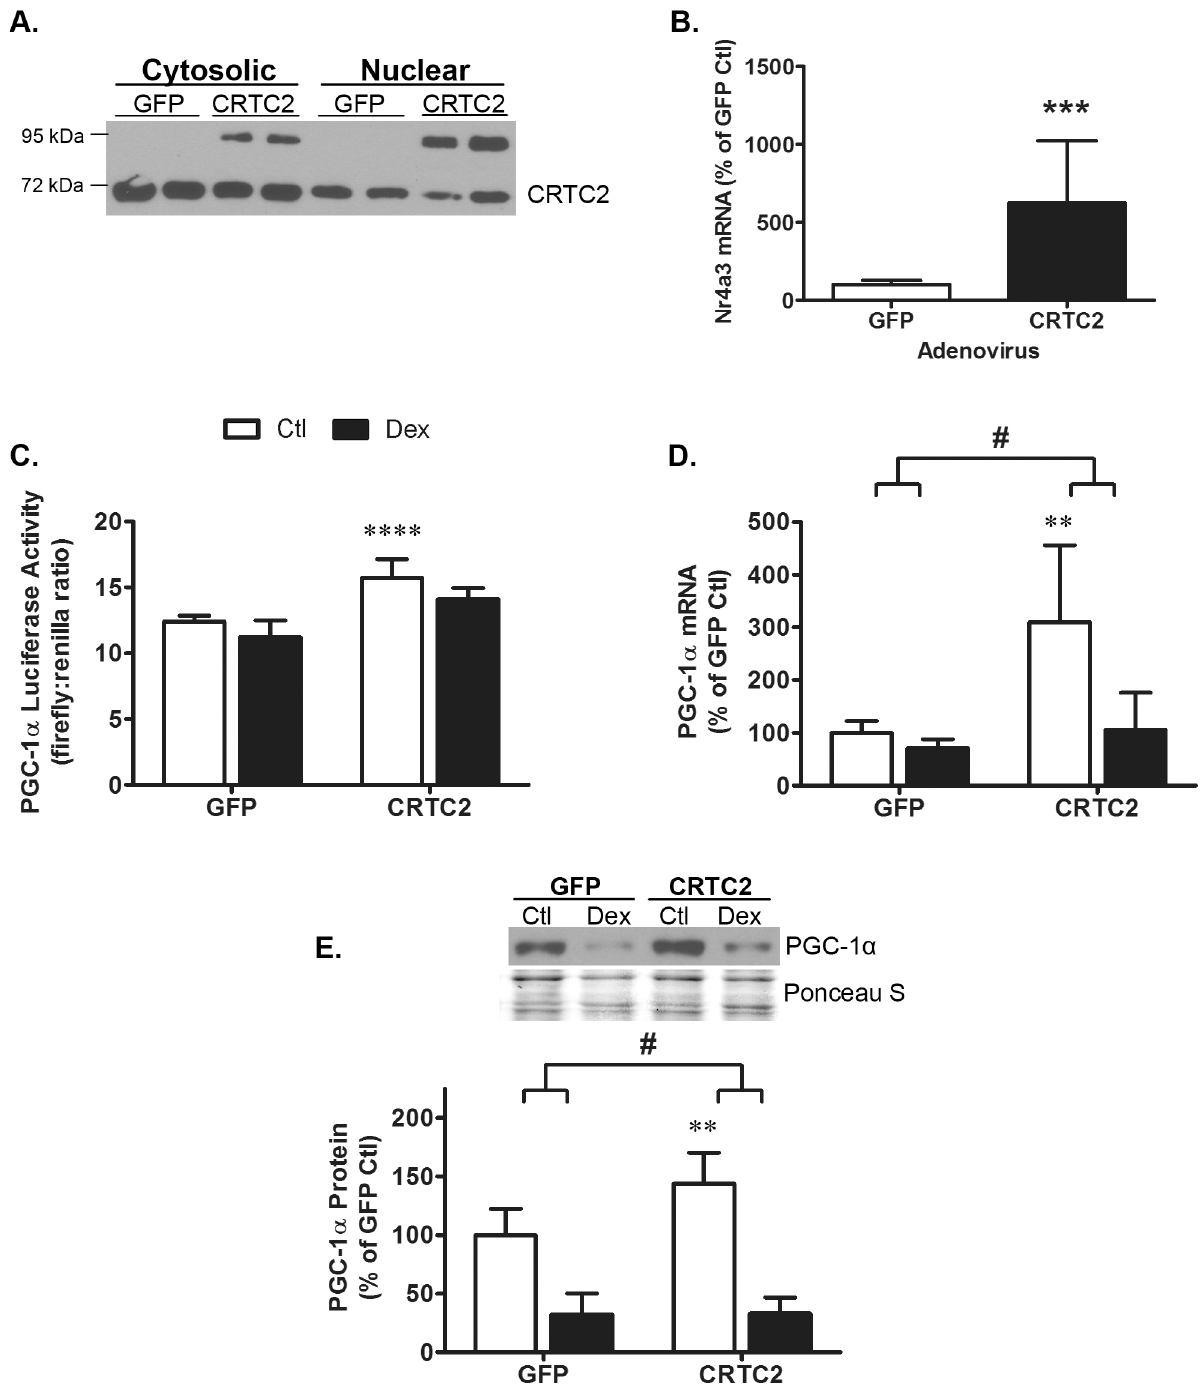
Fig 5. Dexamethasone, CRTC2 and PGC-1 α expression. (A) A representative western blot confirms infection of L6 myotubes with virus encoding CRTC2 increases nuclear CRTC2 protein. Ectopic human CRTC2 protein runs as a ~90kDa protein while the endogenous protein is 67kDa. (B) Overexpression of human CRTC2 increased Nr4a3 mRNA expression as analyzed by Student ’ s t -test (p < 0.001 = *** ). n = 9/ treatment from 3 experiments. (C, D, E) L6 myotubes were infected with GFP- or CRTC2-expressing adenovirus for 24 h then treated with or without 100nM Dex for 48 h. Two-way ANOVA was used to identify effects of CRTC2 overexpression and Dex treatment on PGC-1 α luciferase activity, PGC-1 α mRNA and PGC-1 α protein. (C) PGC-1 α luciferase activity increased with CRTC2 overexpression (p < 0.0001) and decreased with Dex treatment (p = 0.006); ectopic CRTC2 did not prevent the reduction in luciferase activity with Dex (p = 0.6). n = 4/ treatment from 4 experiments. (D) PGC-1 α mRNA expression increased with CRTC2 overexpression (p = 0.0002) and decreased with Dex